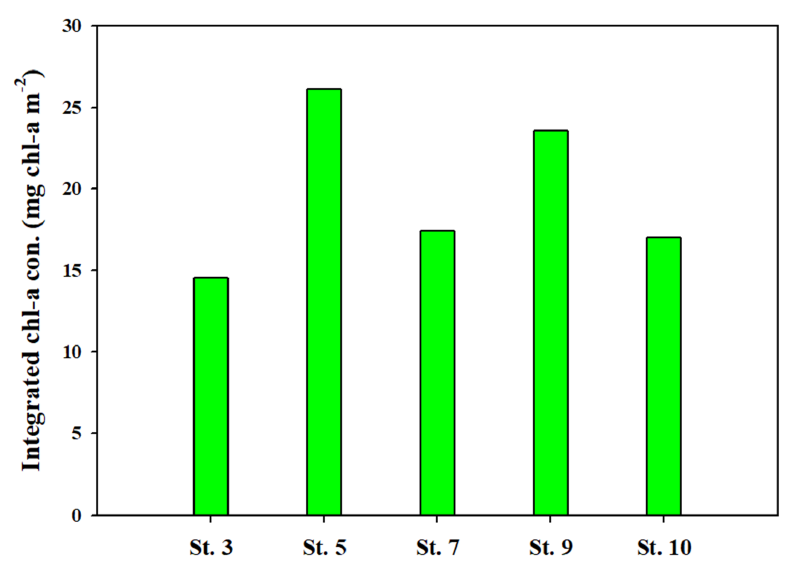
Figure 3. The distribution of chl-a concentrations (mg chl-a m − 2 ) integrated from the surface to 1% light depth at productivity stations.